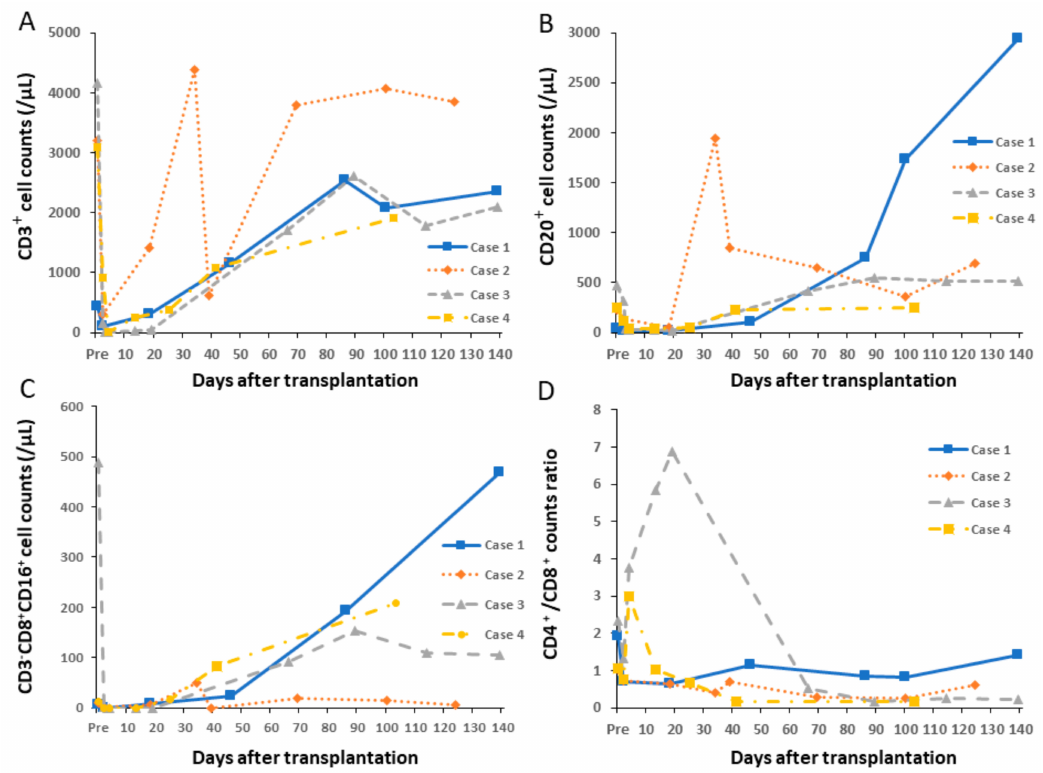
Figure 7. Changes in peripheral cell counts and ratio. ( A ) CD3 + ; ( B ) CD20 + and ( C ) NK cell + counts decreased immediately after induction treatment, and then gradually increased. ( D ) The CD4 + / CD8 + ratio showed a tendency to decrease.